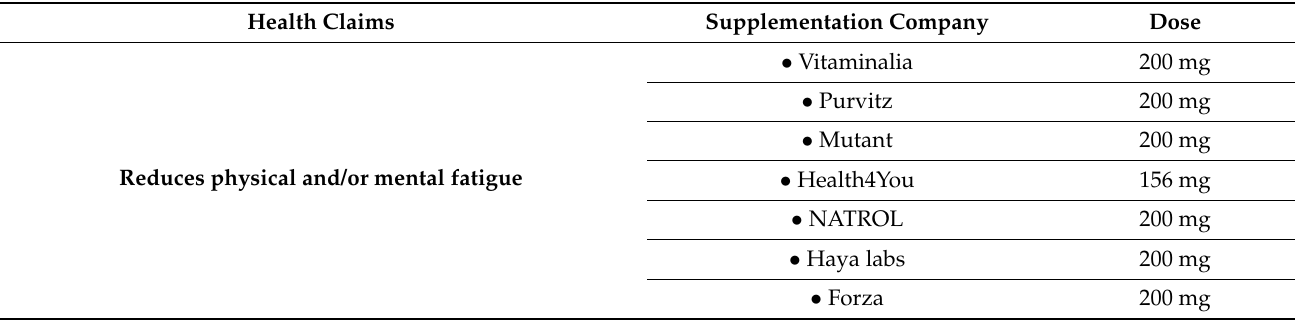
Table A1. Supplementation company and health claims on their